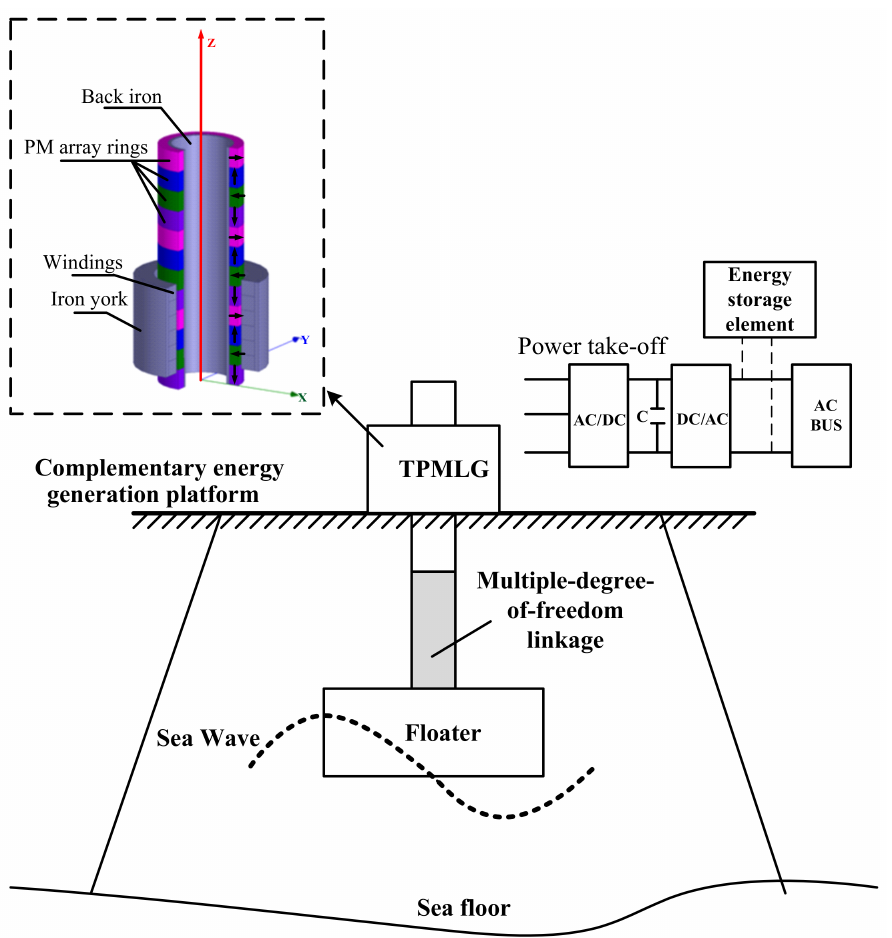
Figure 1. Direct-drive wave energy conversion